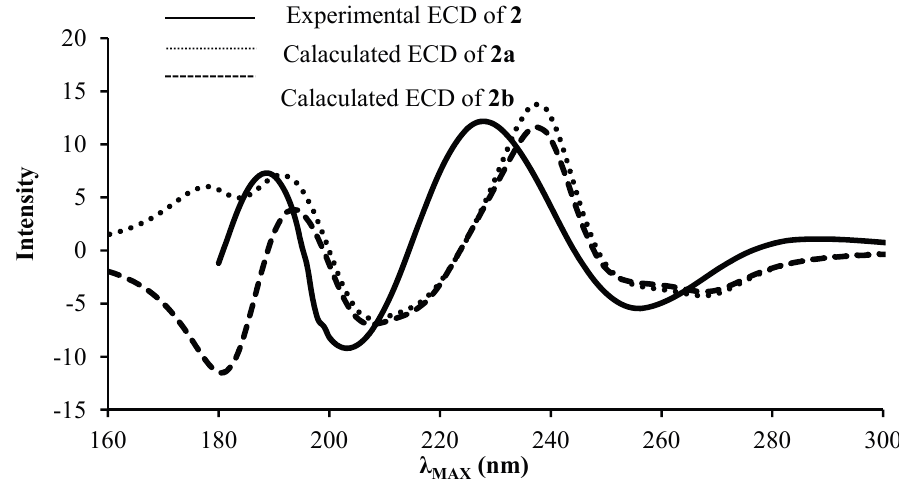
Figure 2. Experimental and predicted ECD spectra of 2a and 2b stereoisomers obtained at the B3LYP/6–31+G(d,p) level of